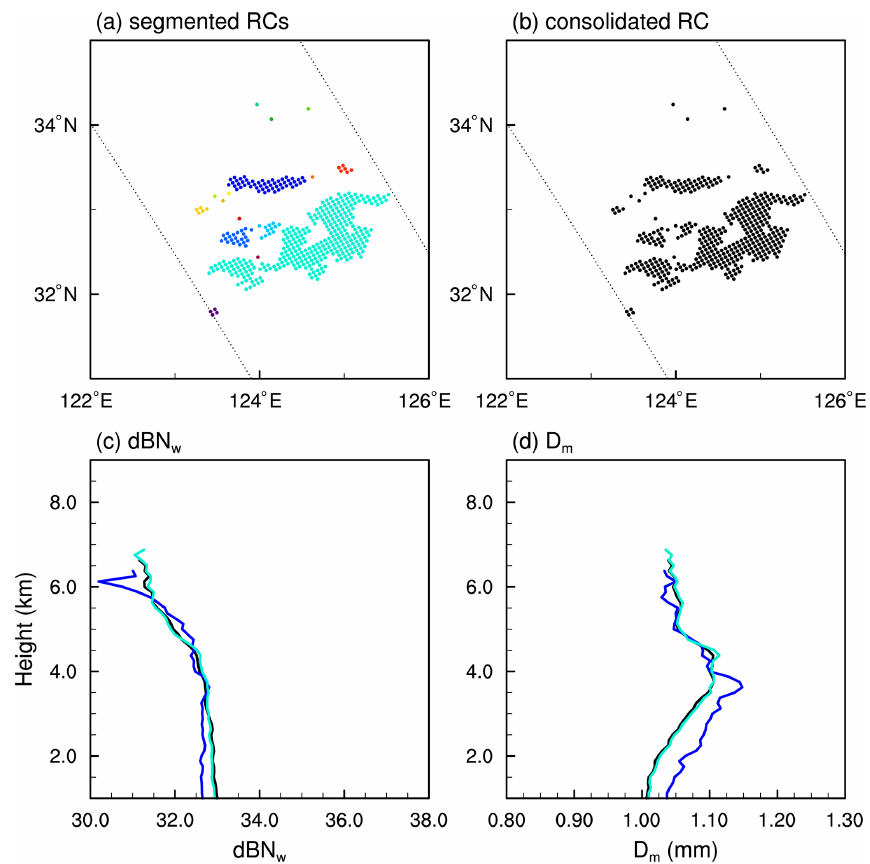
Figure 6. Horizontal distributions of (a) the segmented RCs and (b) the consolidated RC and average DSD profiles (c, d) of them. The colors of the DSD profiles corresponding to the colors of the RCs are shown in panels (a) and (b)